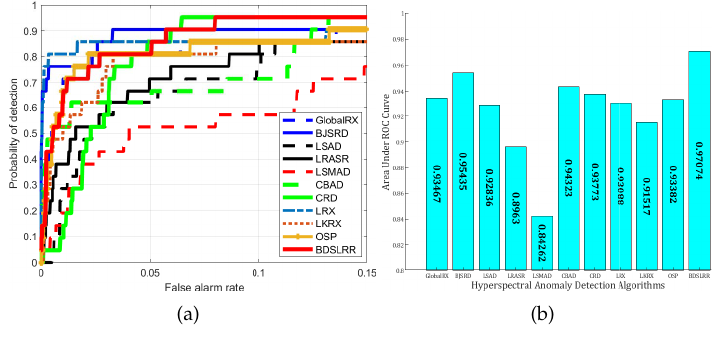
Figure 17. Detection accuracy evaluation for the Urban dataset. ( a ) ROC curves; ( b ) AUC